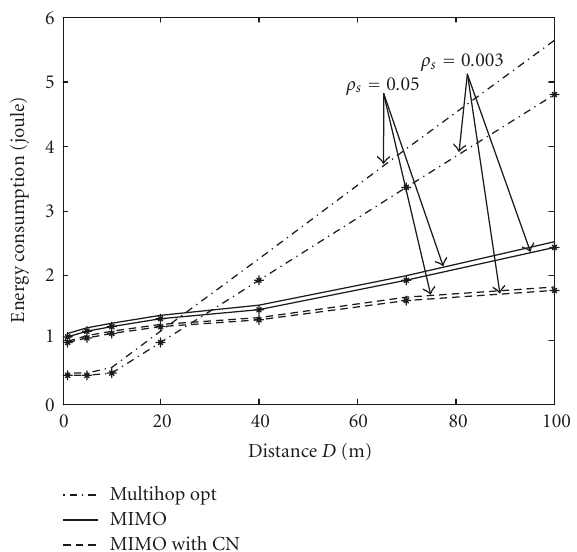
Figure 11: E ff ect of node selection algorithm on thresholds esti- mations when n = 2 . 7 and ( ρ s = 0 . 003) ( M = 30), ( ρ s = 0 . 05) ( M = 500).